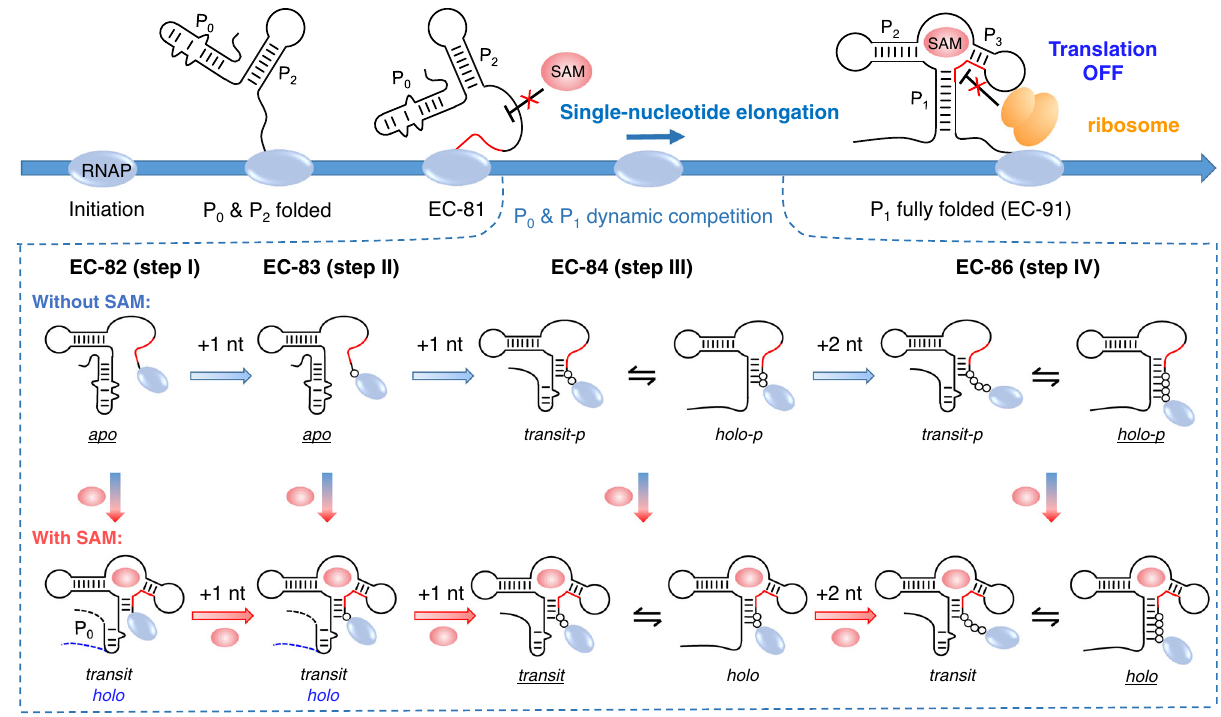
Fig.8|Co-transcriptionalconformationallandscapeofriboSAMintheabsence andpresenceofSAM. The SAM-sensitivetranscriptionwindowofriboSAM (EC-82 toEC-86)isshowninthedottedbox.TheRNAPandSAMareshownasblueandred sphere,respectively.TheRBSisshownasaredline.Thepredominantstructuresare underlined. The DNA templates, apo in the presence of SAM and apo in EC-84/EC-